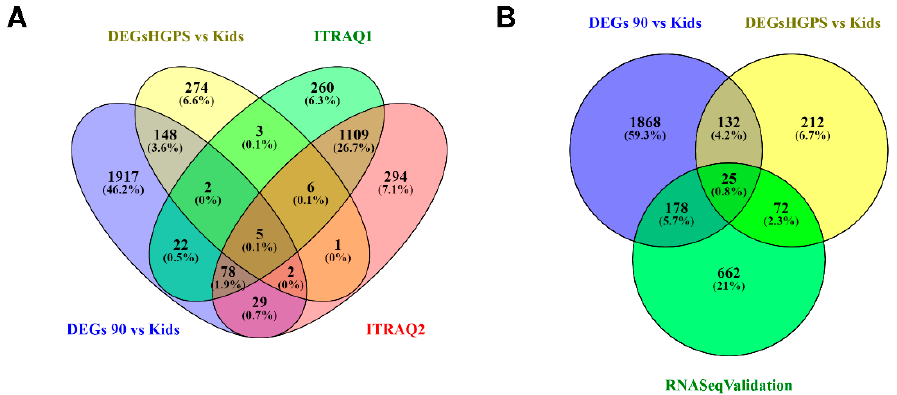
Figure 15. Venn diagram analysis of progeria and aging regarding transcriptomics and proteomics. ( A ) The DEGs of the aging comparison (blue circle) compared with the DEGs of the progeria comparison (yellow circle) and compared with the proteins of the two biological replicates (ITRAQ1 (green) and ITRAQ2 (red circle)) analyzed by Mateos and colleagues (2018, available in their Supporting Information [107]). ( B ) Comparison of the DEGs of the aging comparison (blue) and the DEGs of the progeria comparison (yellow) compared with the DEGs of the RNA-Seq analysis by Mateos et al. (2018; available in their Supporting Information [107]; green circle). Table 3. Summary of the DEGs of special interest in the different proteomics studies. Columns in-